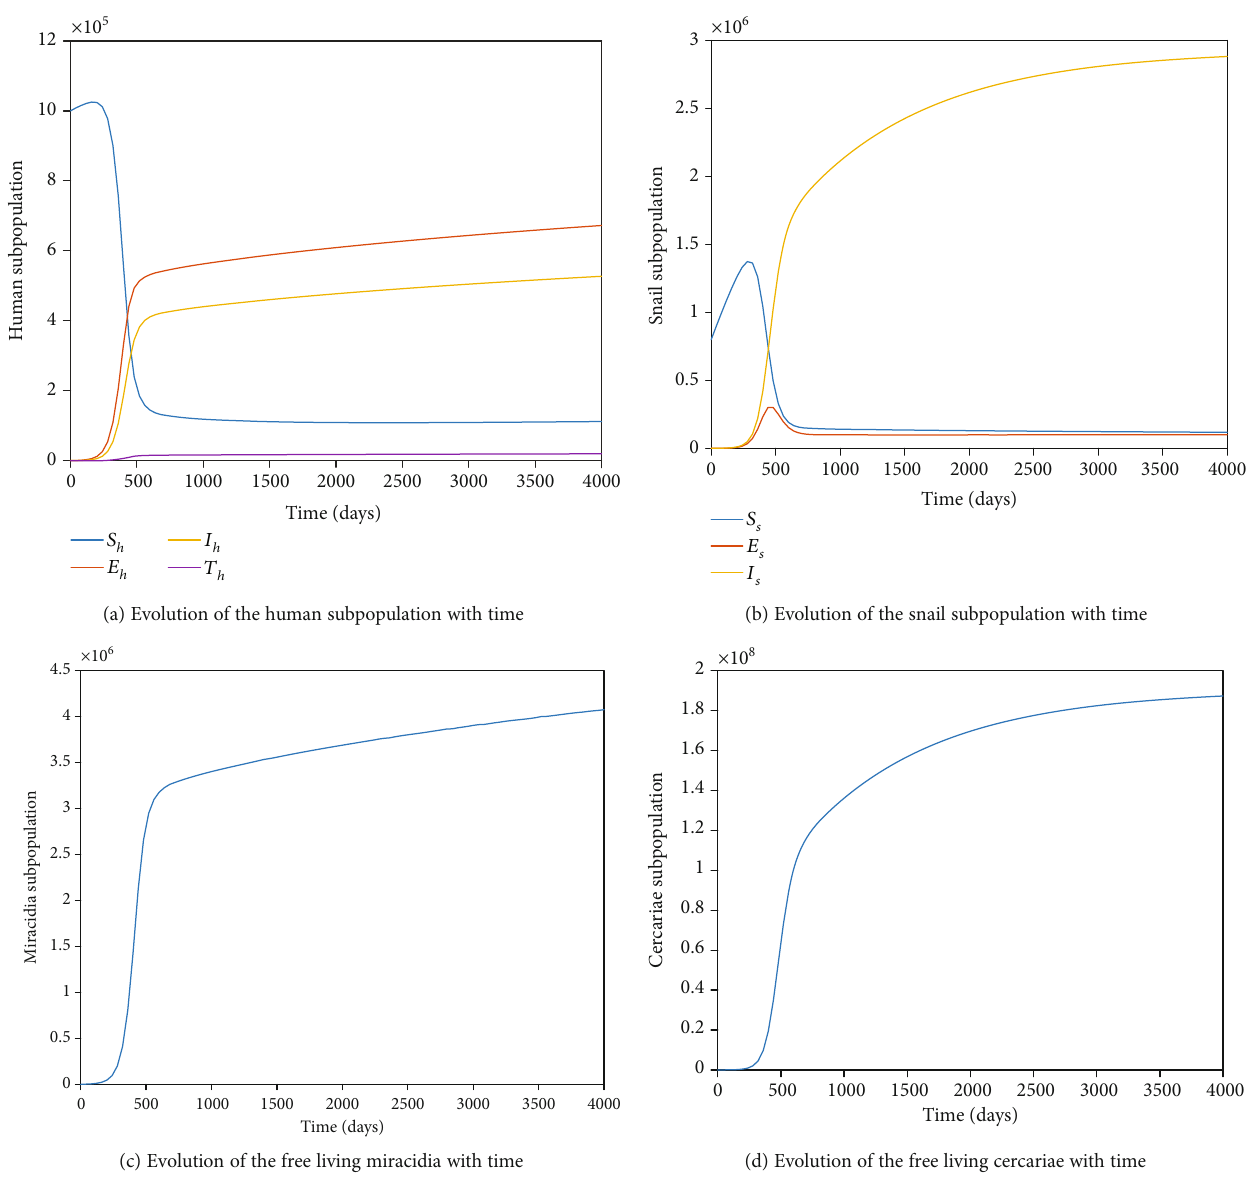
Figure 3: Evolution of each subpopulation with